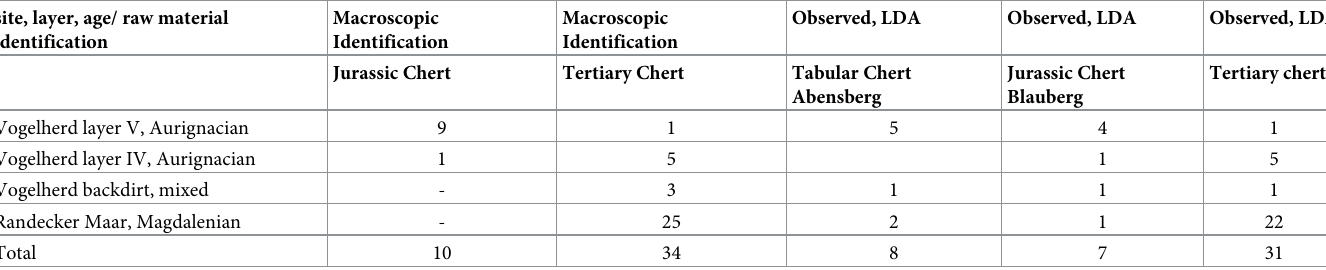
Table 3. Summary of the predictions of the macroscopic analysis and the predictions of the LDA.